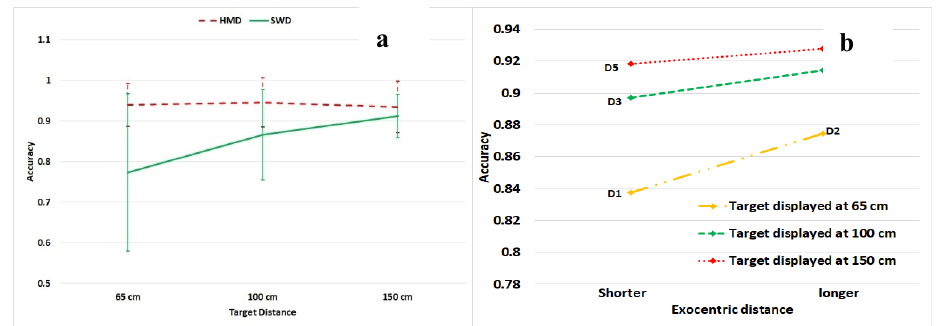
Figure 4. ( a ) Exocentric distance estimation accuracy with respect to target distance, where the significant effect of target distance observed in the SWDs. This phenomenon could be explained by accommodation–convergence conflict at the nearest target distance [11,32]; ( b ) the main effect of exocentric distance on distance judgment accuracy. It shows that the overall distance judgment accuracy increases as exocentric distance increases.